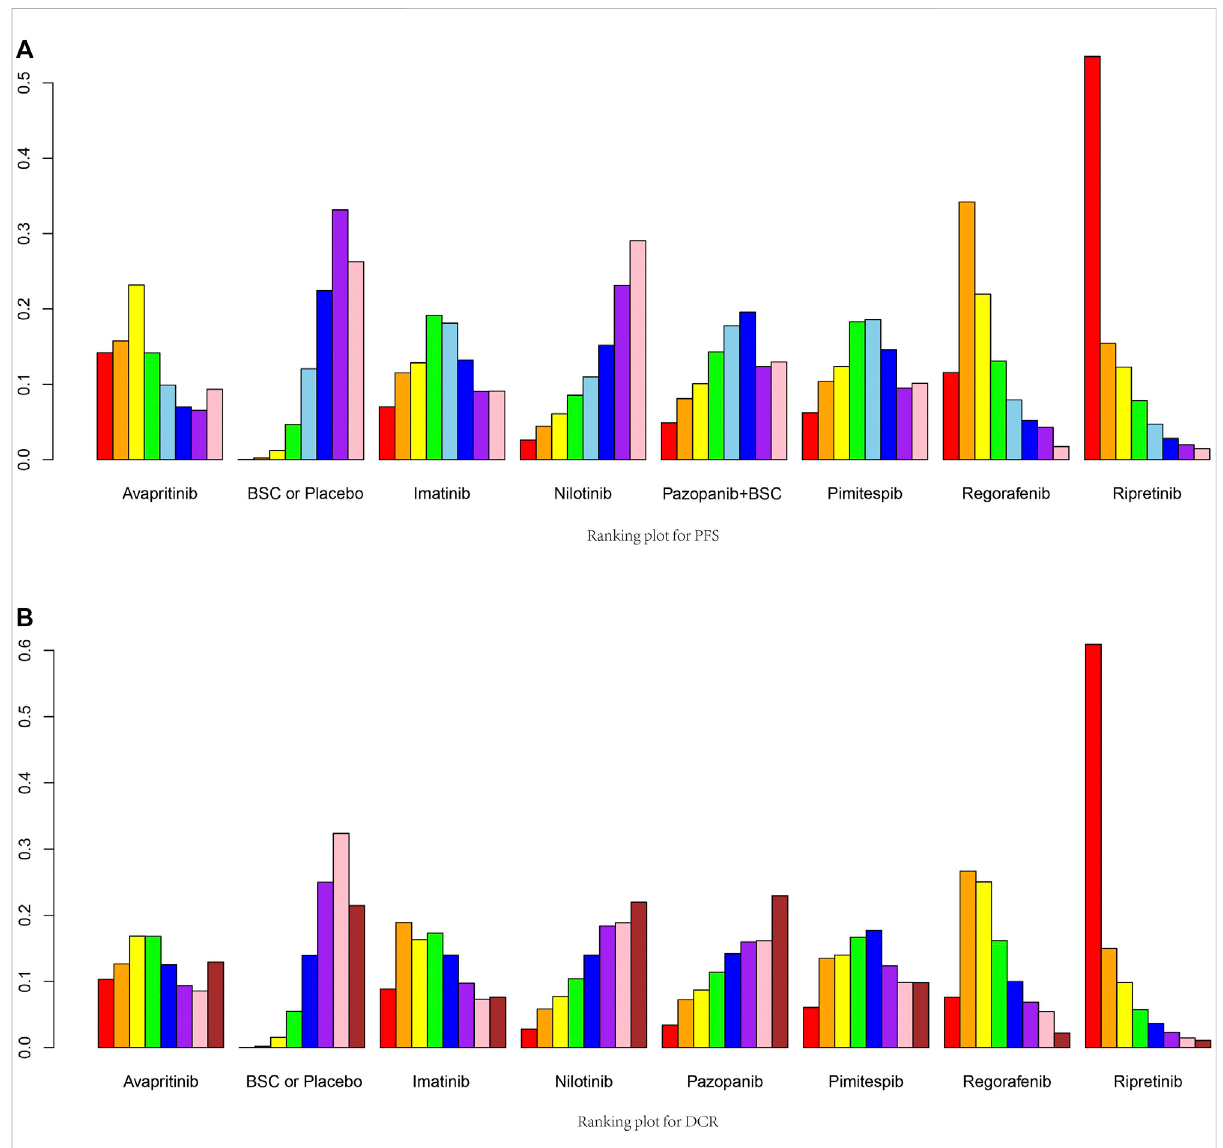
FIGURE 3 Ranking plot for PFS and DCR. (A) Ranking plot for PFS. (B) Ranking plot for